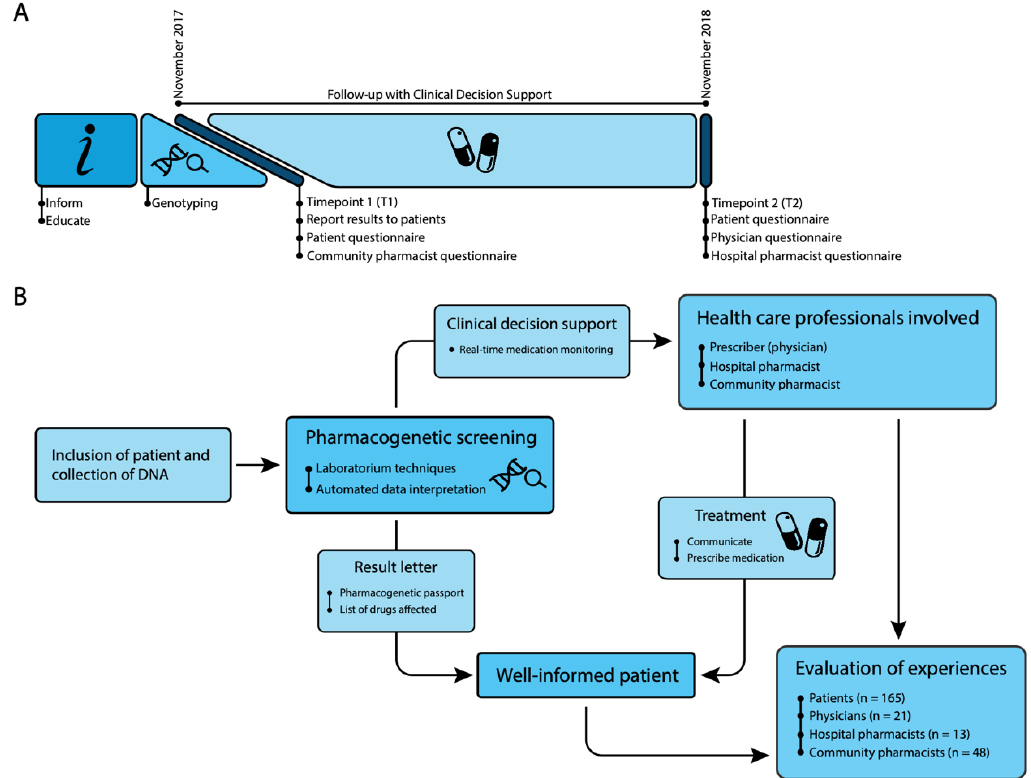
Figure 1. Study timeline and design ( A ). Study timeline ( B ). Study design.